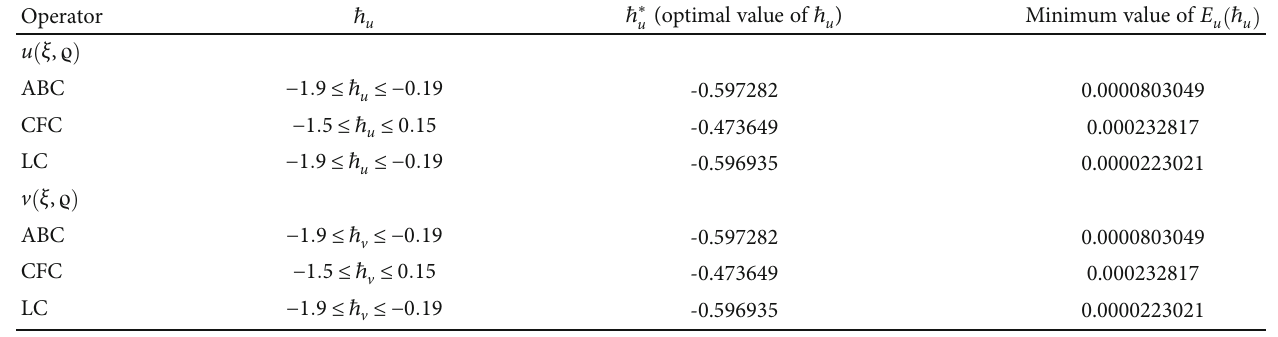
u , v and minimum values.